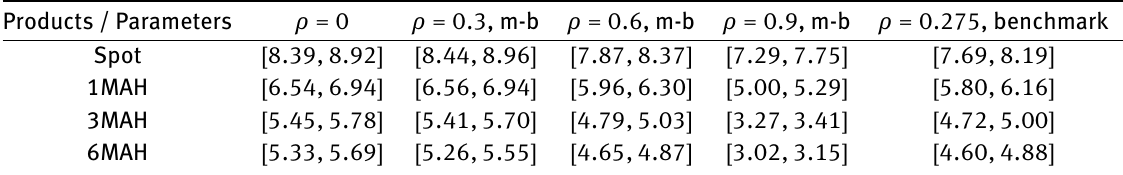
Table 2: Values of European Spread options ( X t − HY t ) + between electricity and coal products in the benchmark model and in the multi-barrier correlation model with parameters ν = 0 , η = 0.5 with X 0 = HY 0 = 100 . Products / Parameters